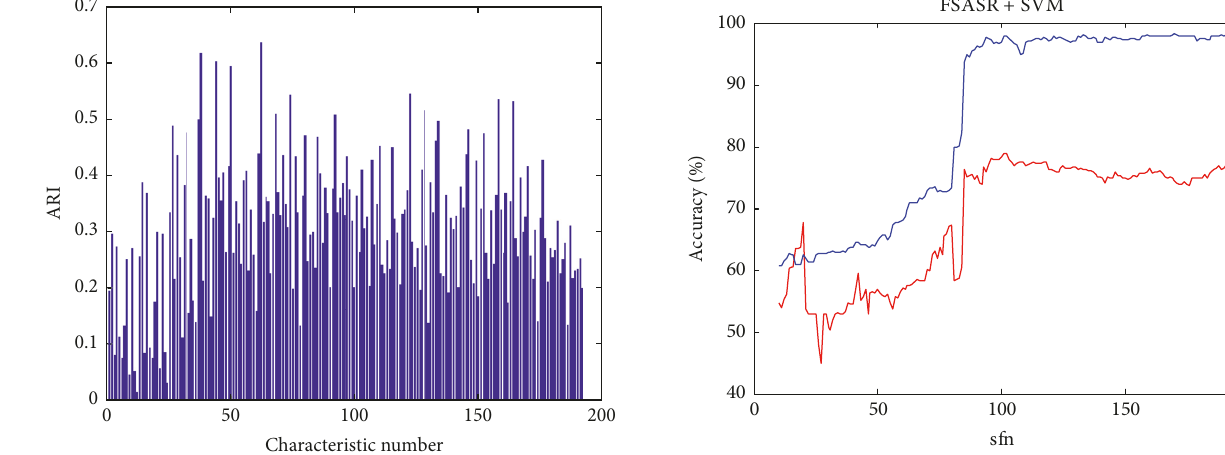
Figure 26: The ARI of 192 statistical characteristics of training samples.